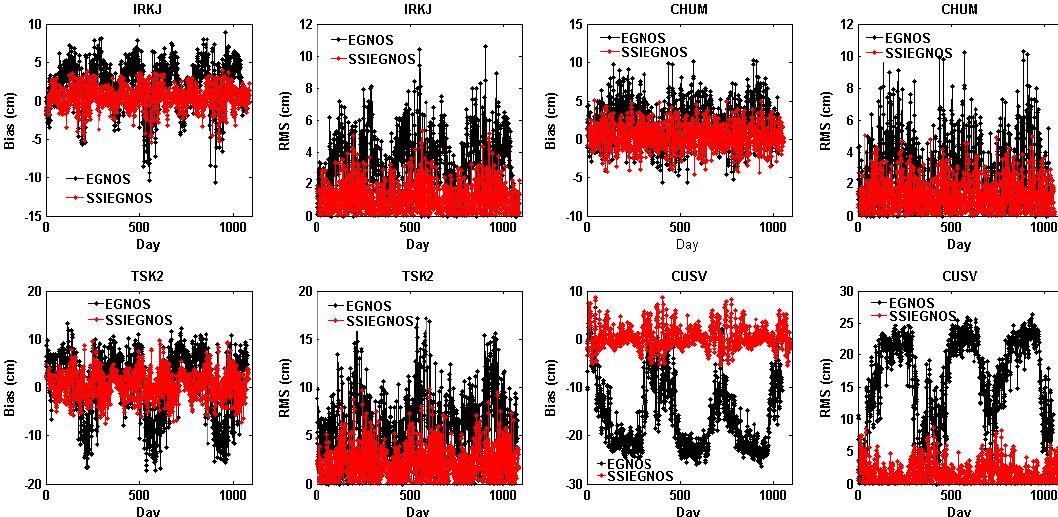
Figure 3. Variation of the daily bias and RMS in 2008–2010 at sites IRKJ, CHUM, TSK2, and CUSV for the EGNOS and SSIEGNOS models. The black line represents EGNOS model and the red line represents SSIEGNOS model.